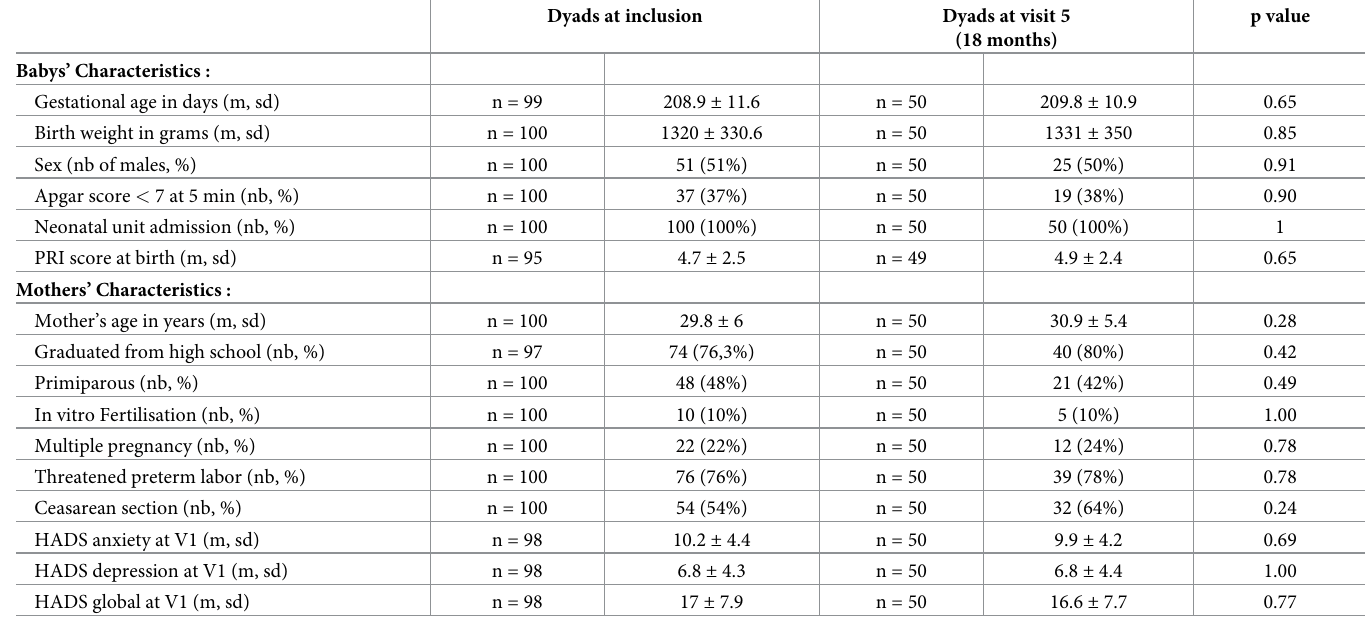
Table 2. Socio-demographic and clinical characteristics of the dyads at inclusion and at 18 months after delivery (during visit 5).